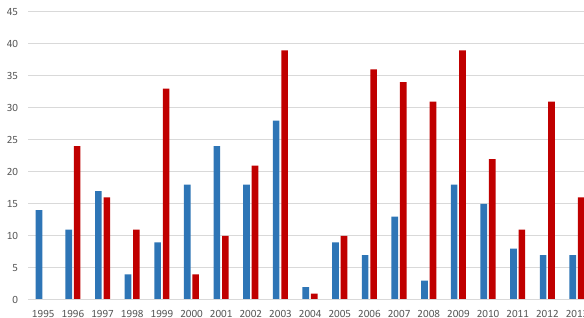
Figure 2. Number of provinces affected by heat waves (red) and significant negative yield anomalies (in blue) in the period 1995–